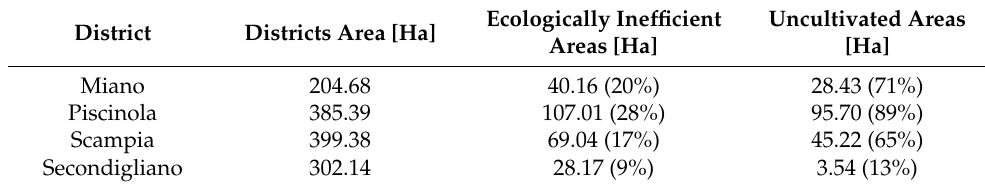
Table 4. Statistics of districts by uncultivated